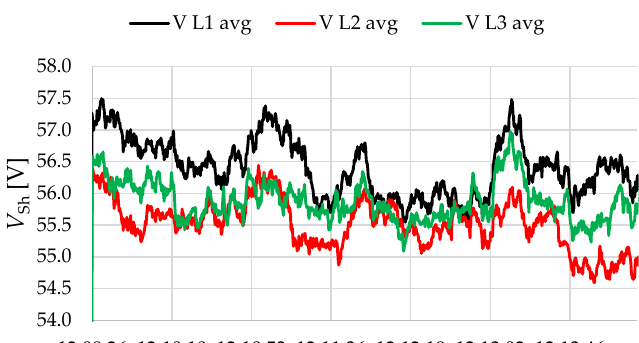
Figure 16. Sheaths voltages measured in Substation 2. Case Sh3—sheaths cross-bonded according to: L1 → L2, L2 → L3, L3 → L1. Operation only with the analyzed line.